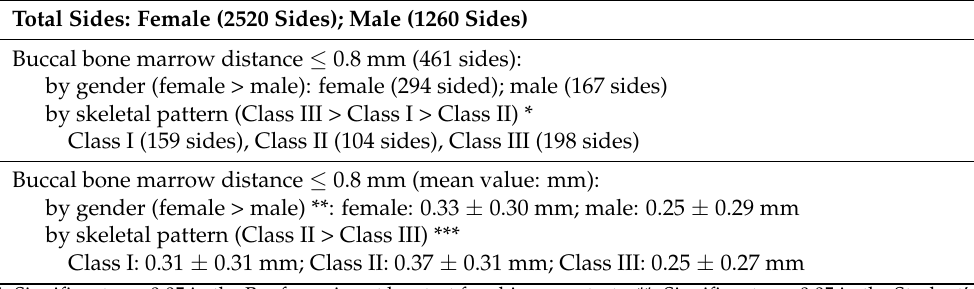
Table 4. The summary of the characteristics of a total of 1890 slices (3780 sides).